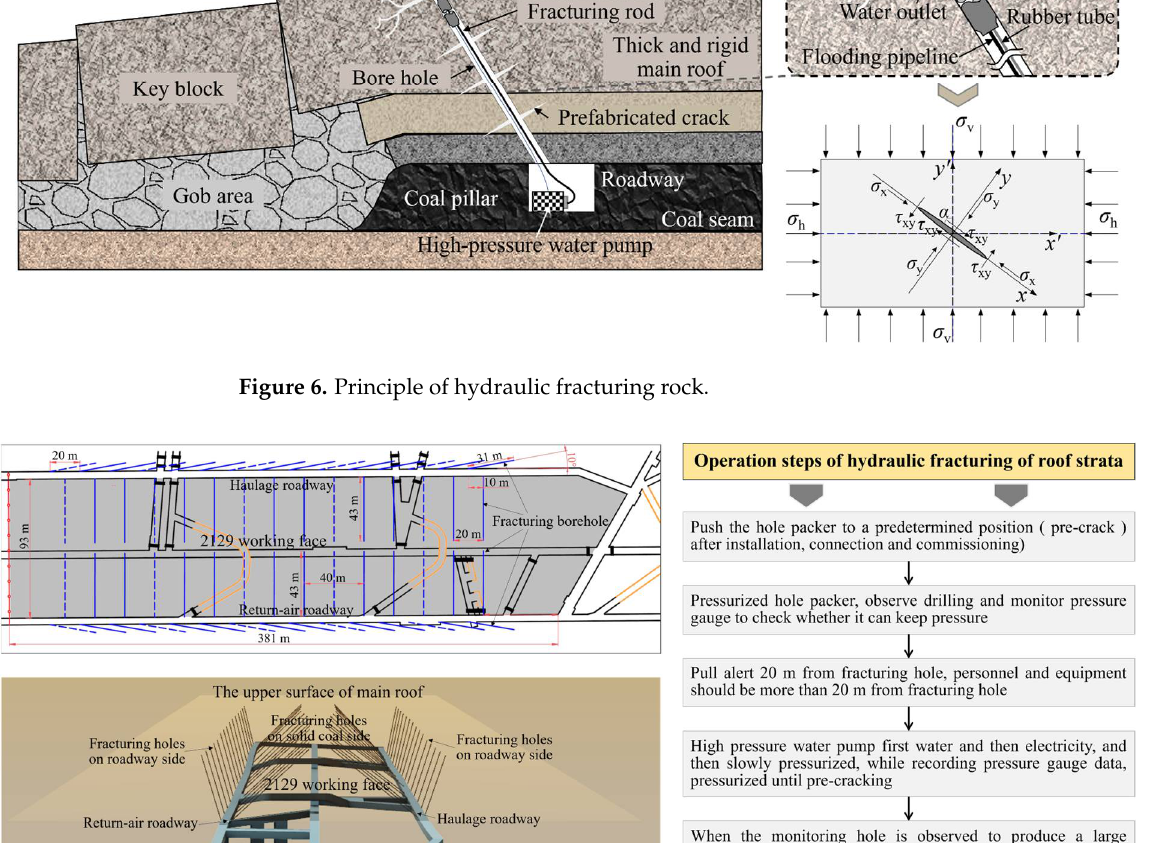
Figure 6. Principle of hydraulic fracturing rock.